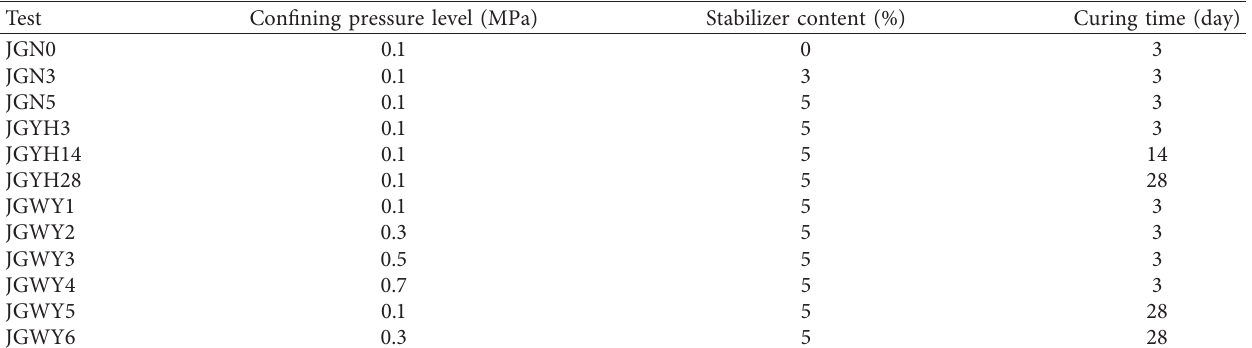
Table 4: Test procedures of stabilized soils.